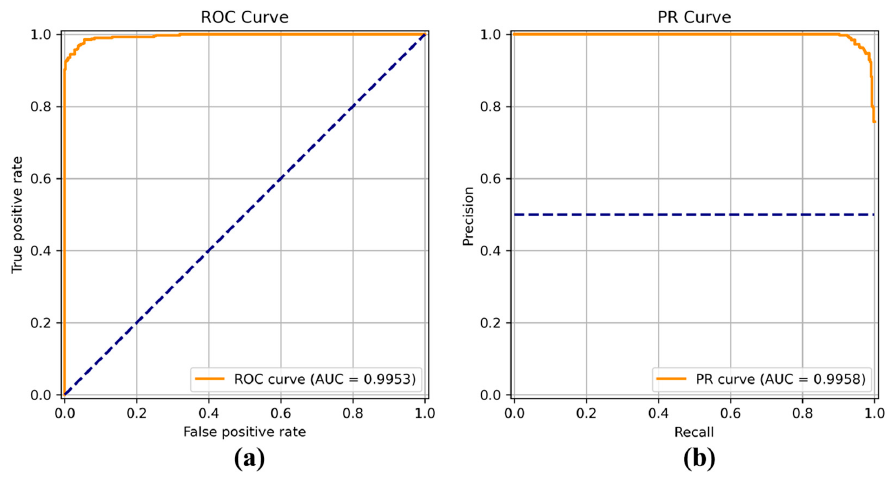
Figure 9. ( a ) Receiver operating characteristic (ROC) curve and ( b ) precision recall (PR) curve of DenseNet.